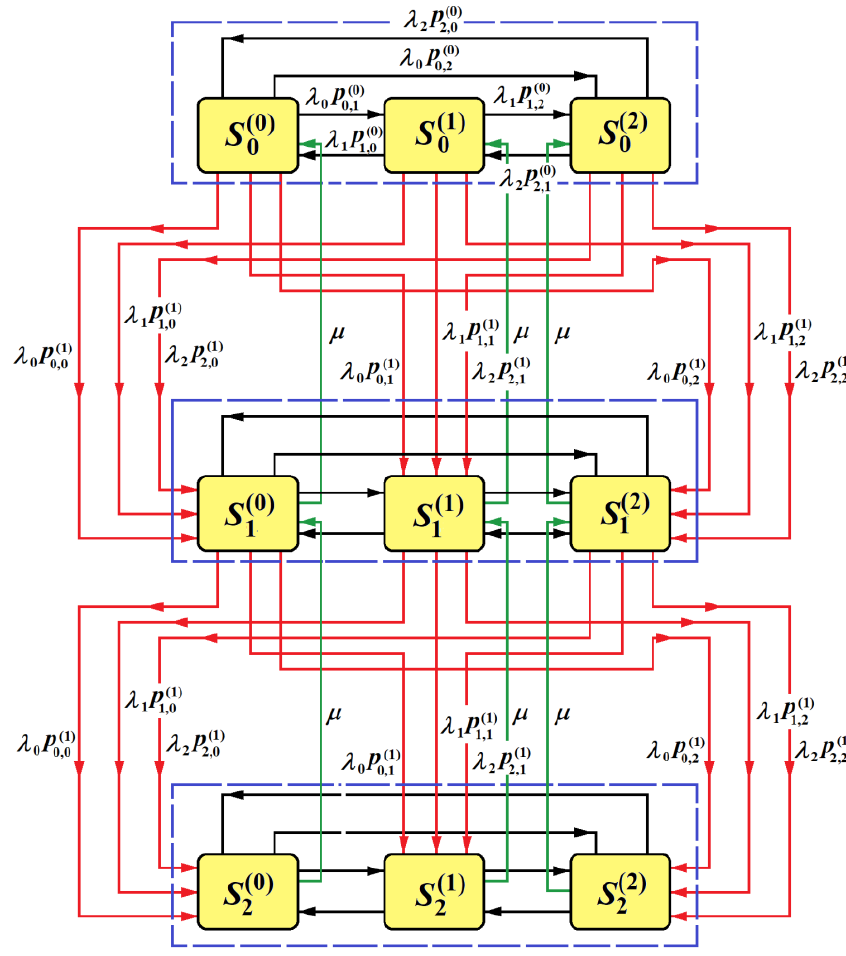
Figure 3. Transition graph of the MAP / M /1/ N system.